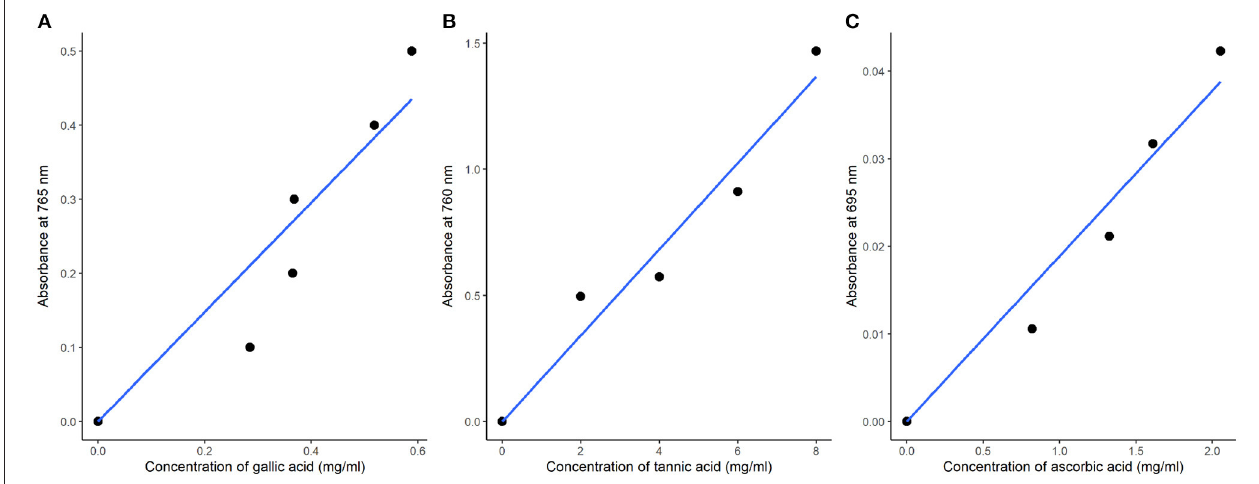
FIGURE 1 | Standard calibration curves of total phenolic compounds (A) , total tannins (B) , and total antioxidant activity (C) of leaves of spider plant.